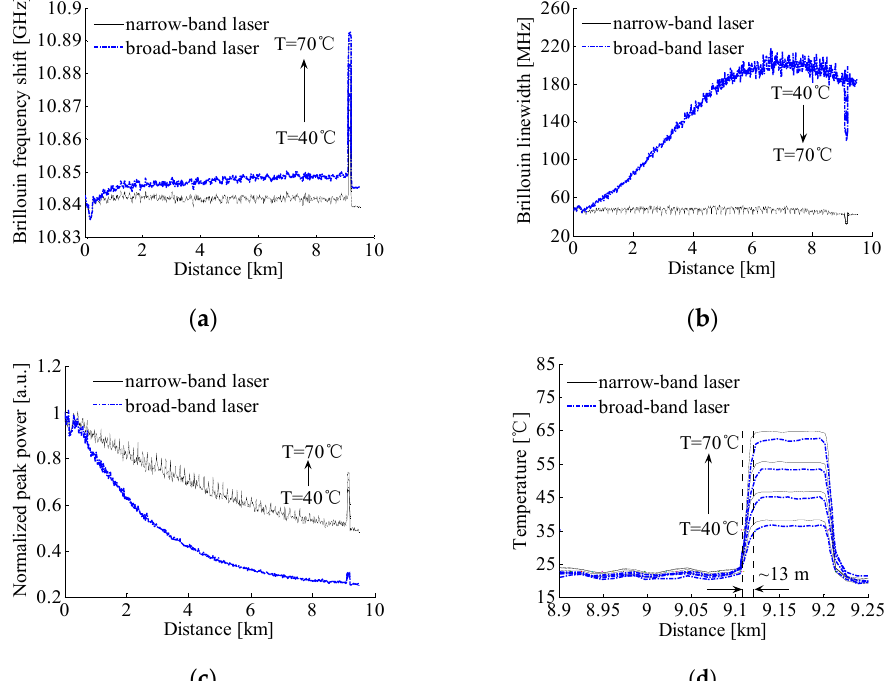
Figure 7. Distribution of Brillouin signals and demodulated temperature along the fiber obtained by local heterodyne detection system: ( a ) Brillouin frequency shift; ( b ) Brillouin linewidth; ( c ) Brillouin peak power; and ( d ) temperature.